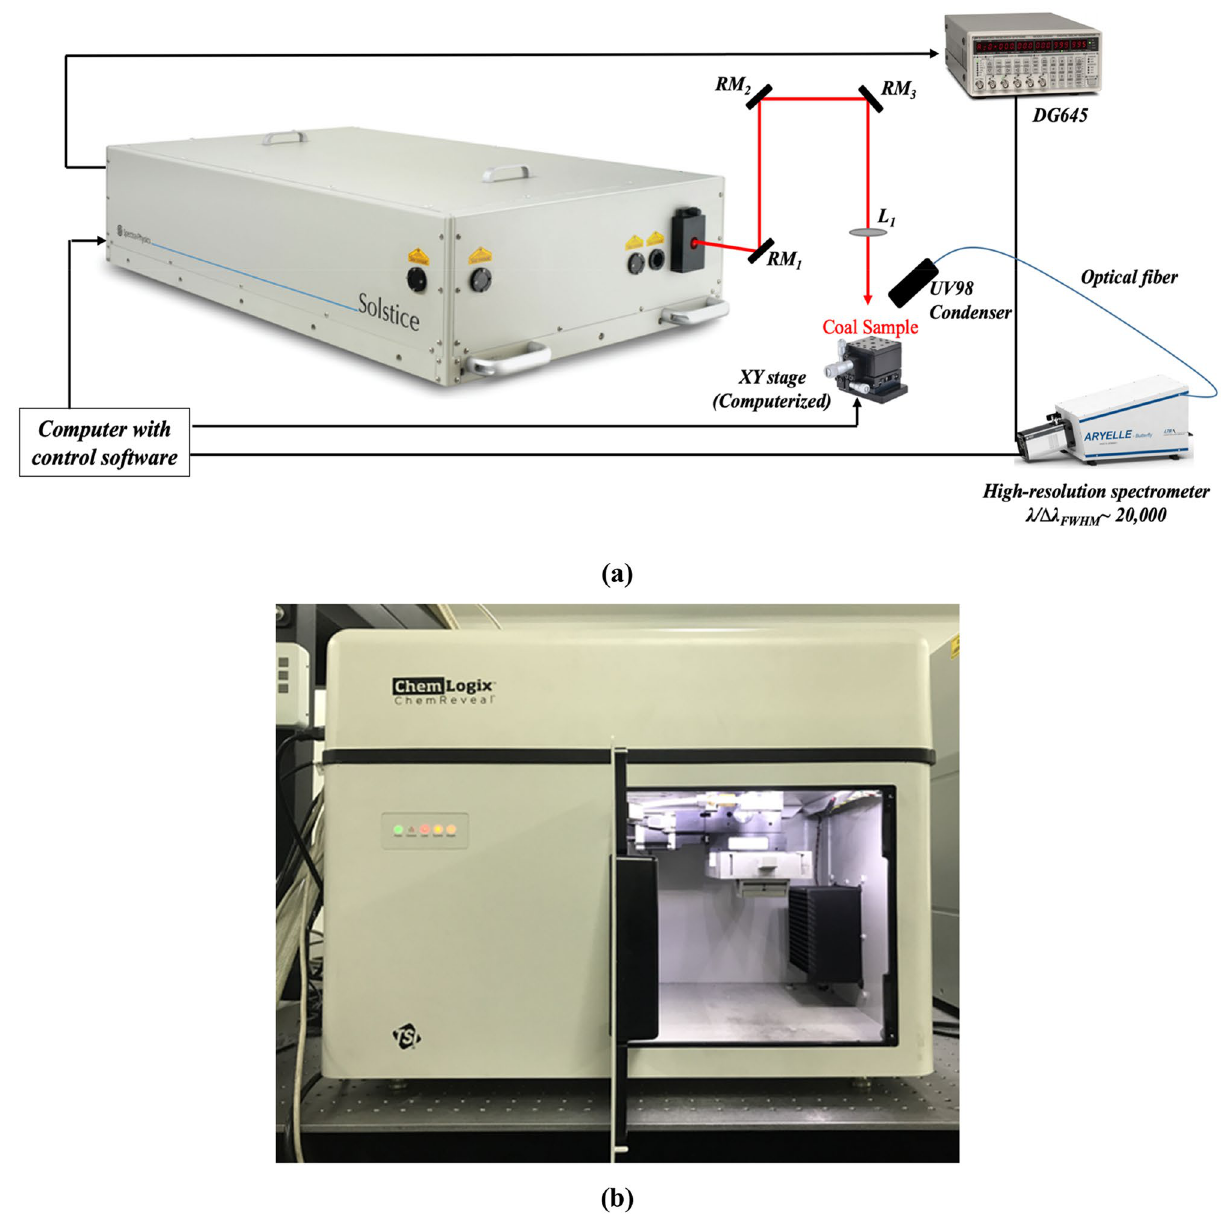
Figure 13. ( a ) Schematic diagram (not to scale) of fs-Solstice system under evaluation. RM: ultrafast 730– 820 nm reflecting mirrors; L 1 : focusing lens ( f = 200 mm); ( b ) Image of ns-Chem system—an industrially-applied ns-LIBS coal analyzer (offline mode of operation). Photographs courtesy of Sahar Sheta. Copyright